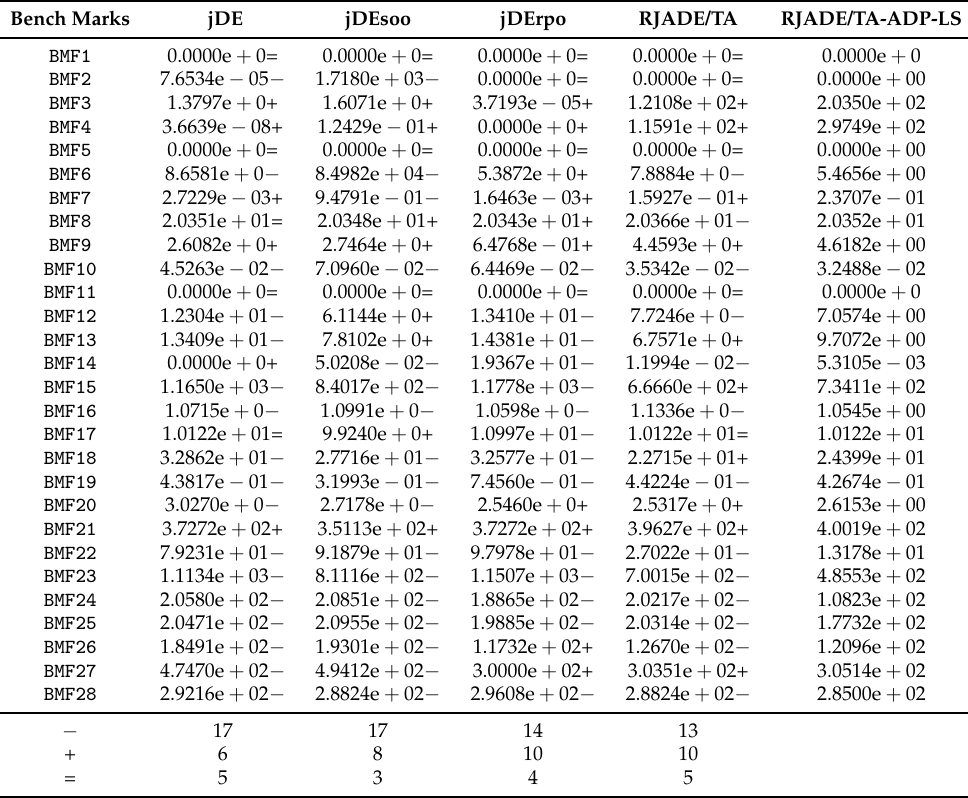
Table 2. Comparison of RJADE/TA-ADP-LS with Well Established